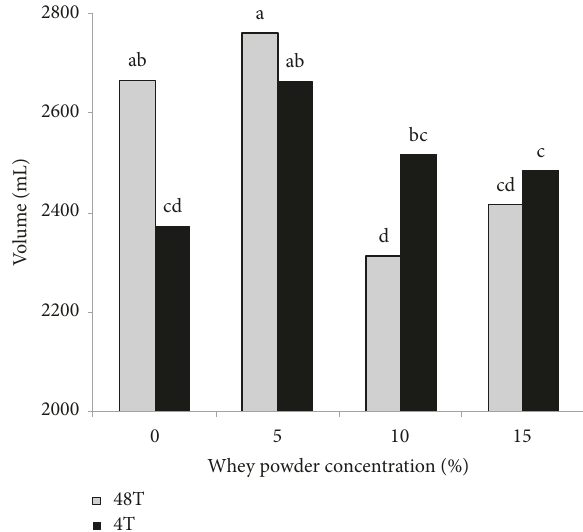
Figure 1: Volume of pan bread (mL). Samples with different letters are significantly different at 𝑝 < 0.05 according to Duncan’s multiple range test.